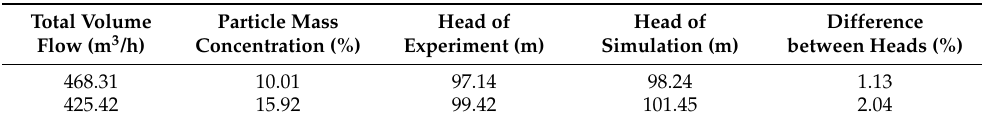
Table 7. Comparisons of experimental and simulation